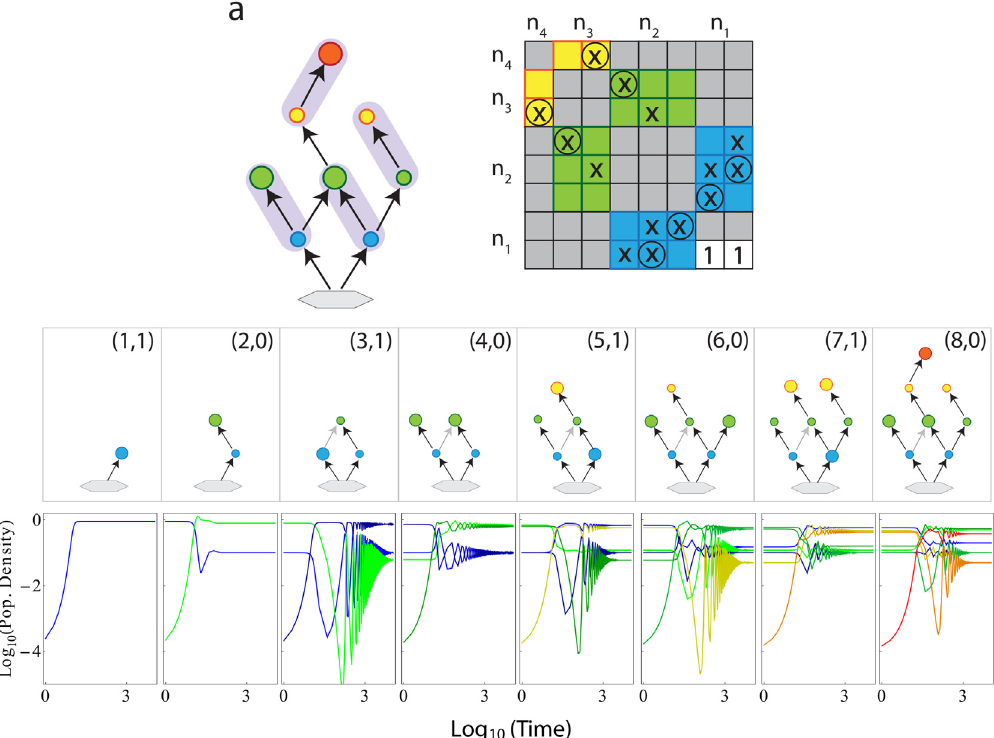
Fig 3. Food web assembly. a , Consumer limited food web and its interaction matrix. The symbols “ × ” mark nonzero entries and circles a path through the matrix. Basic nutrient is shown as a gray hexagon, whereas species on subsequent trophic levels are shown with coloured circles. Small circles highlight limitations by consumers. Shaded ovals indicate possible pairing of species. b , Possible assembly of the food web in (a) with labels for N o + N e and N o − N e . We set all growth and coupling constants equal to unity, but consider fine-tuned decay coefficients α (cid:5) 1 (details: [38], in prep.). Note the transitions between biomass limiting states. Sizes of circles indicate approximate densities of species in the different states. Link shown in gray was set to zero in the numerical simulations in (c). c , Species added one-by-one as shown in (b) and granted small initial population density (10 − 4 ). After each addition the system is integrated until steady state is reached. In the plot, colors of curves denote species of similar colors in the panels of (b). Note the double-logarithmic axis- scaling in (c). Time in each panel is relative to the time of introduction of the new species.